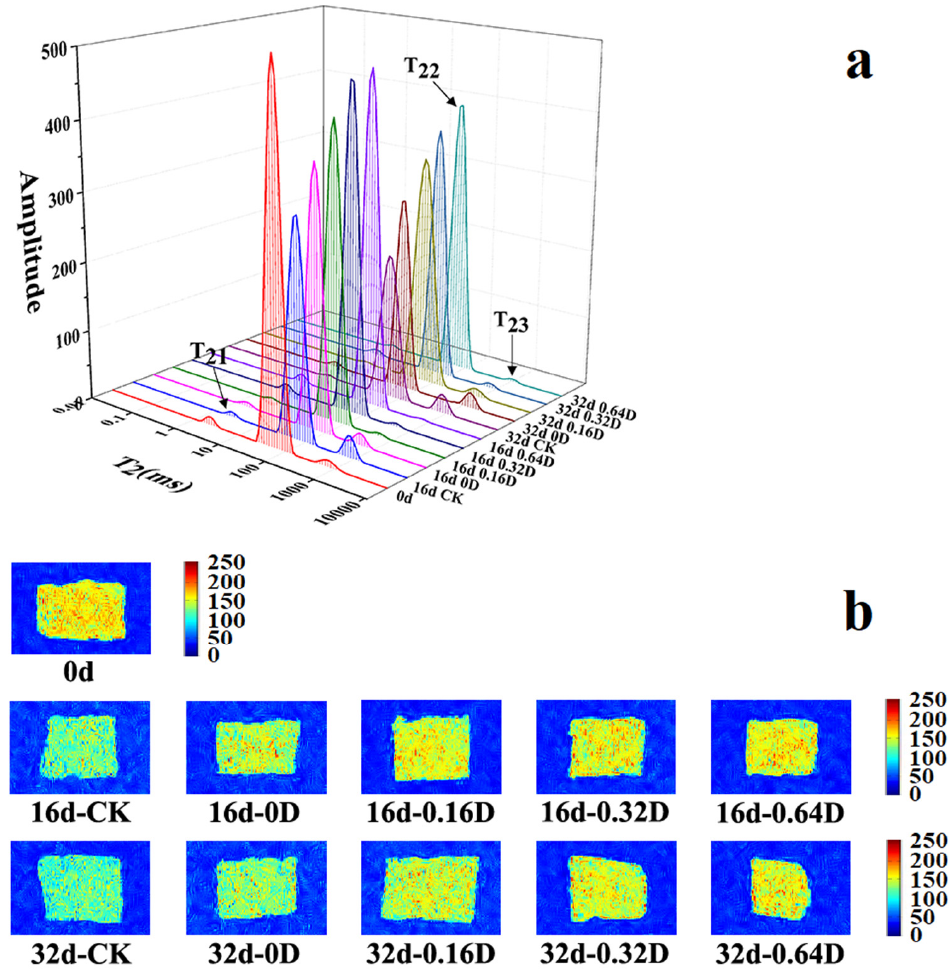
Figure 2. Changes in the water distribution ( a ) and MRI ( b ) of turbots during refrigerated storage.